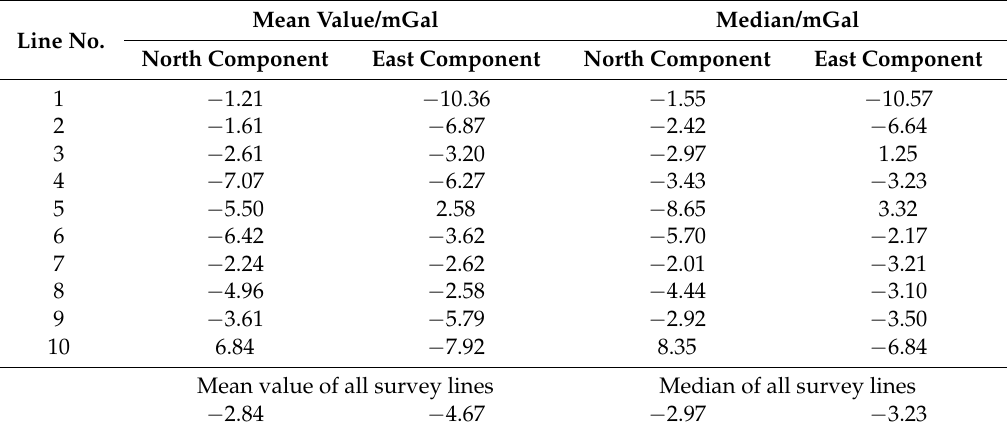
Table 2. The statistical values of horizontal gravity disturbance on the survey lines.